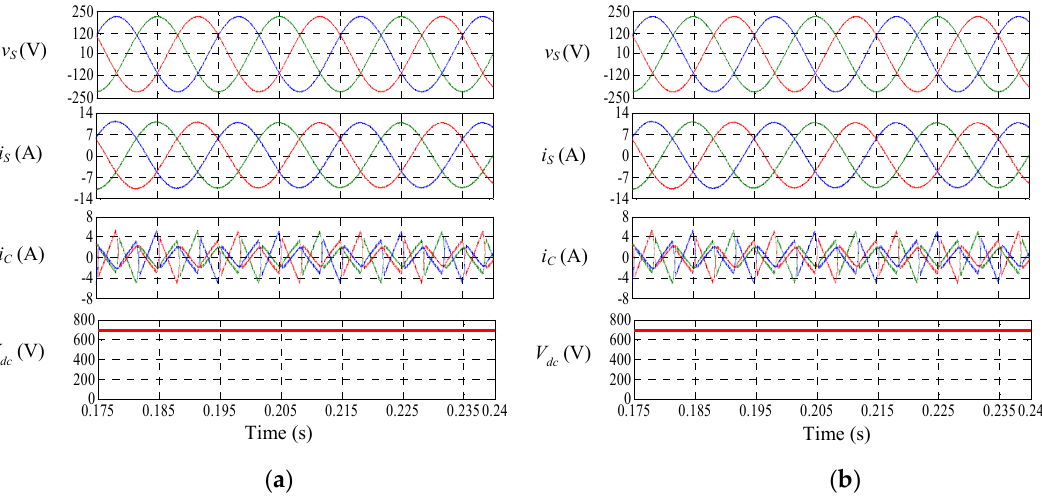
Figure 10. FFT analysis of the source current after compensation obtained from SAPF ( a ) with FLC and ( b ) without FLC.